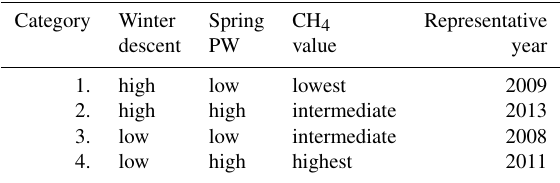
Table 1. Categorization of summer upper stratospheric CH 4